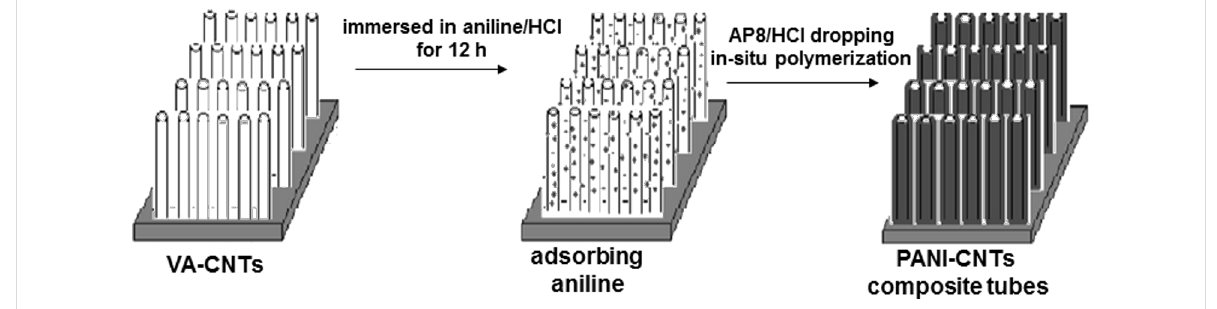
Figure 18: Preparation procedure for organizing PANI/MWCNT nanocomposite-tube films. (a) Aligned MWCNT film grown on quartz substrate by catalytic pyrolysis. (b) The aligned MWCNT film immersed into aniline/HCl solution at 0 °C for 12 h. (c) Polymerization takes place on the MWCNT surface and forms an ordered PANI/MWCNT nanocomposite-tube film. Adapted with permission from [140]. Copyright 2003